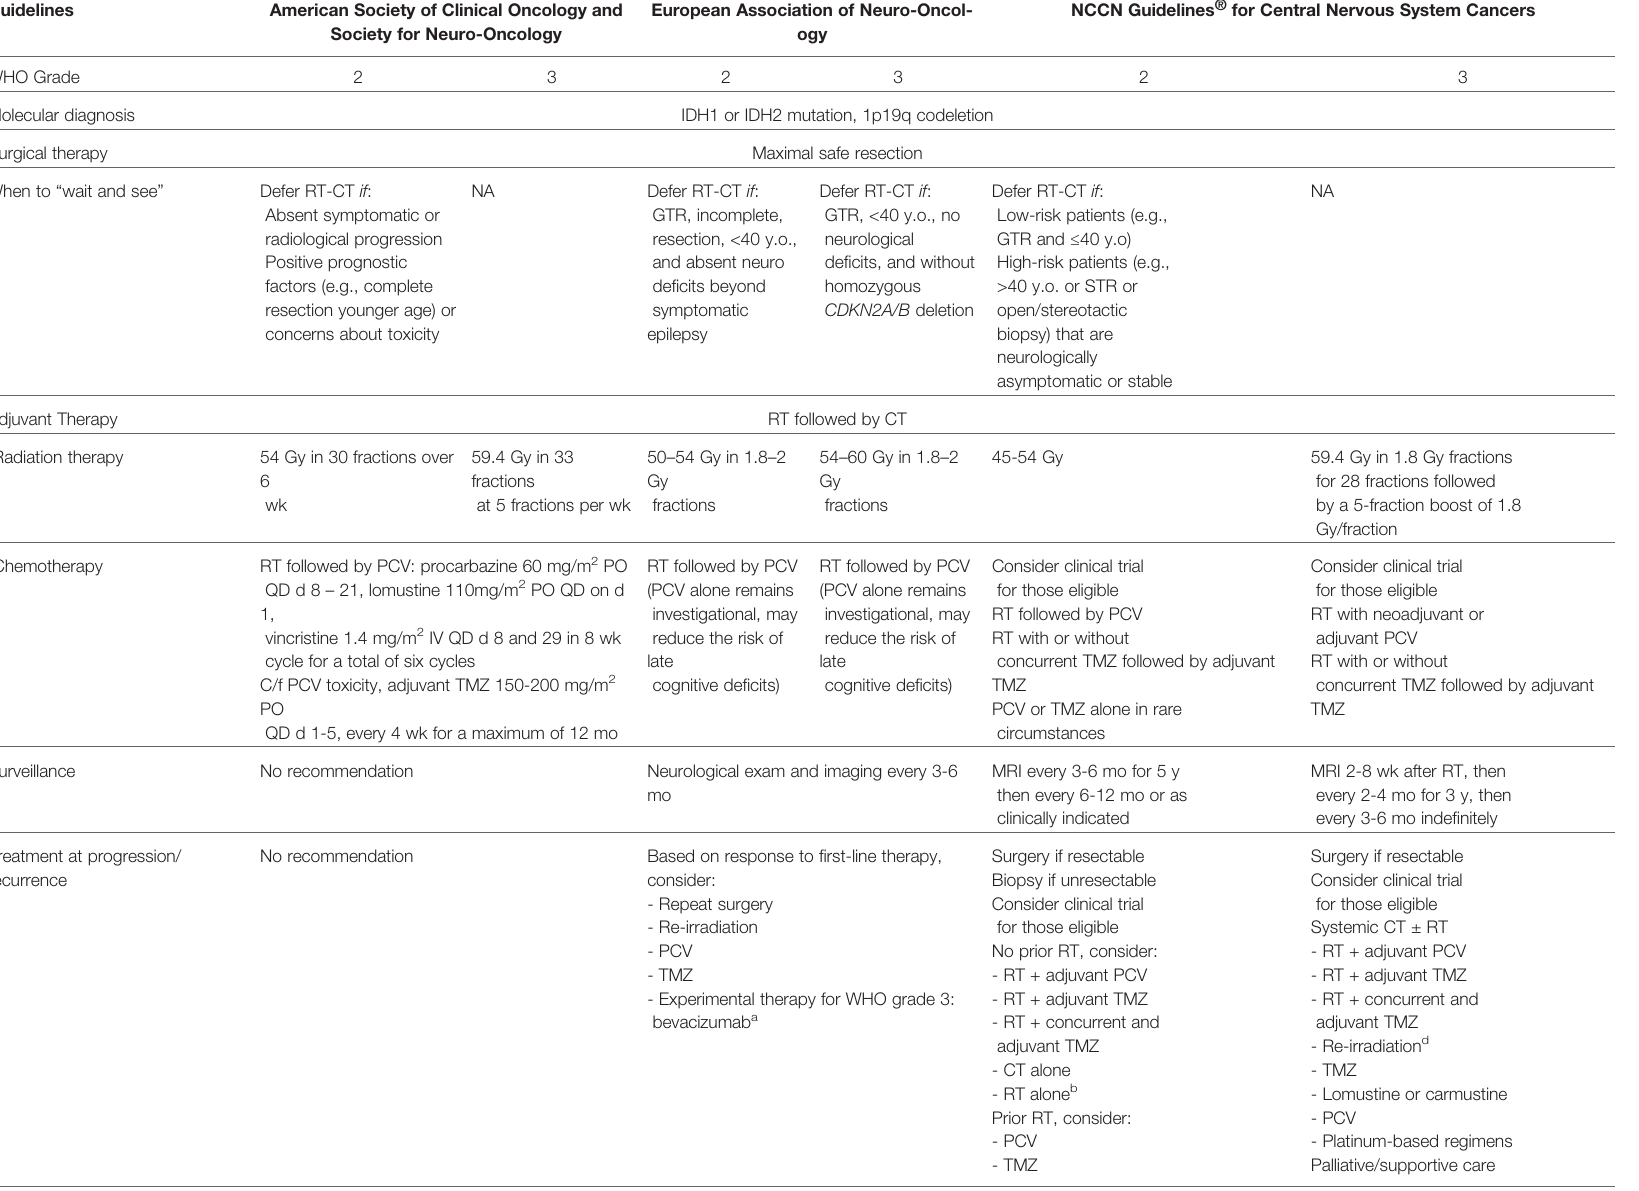
TABLE 1 | Societal guidelines for oligodendroglioma management.